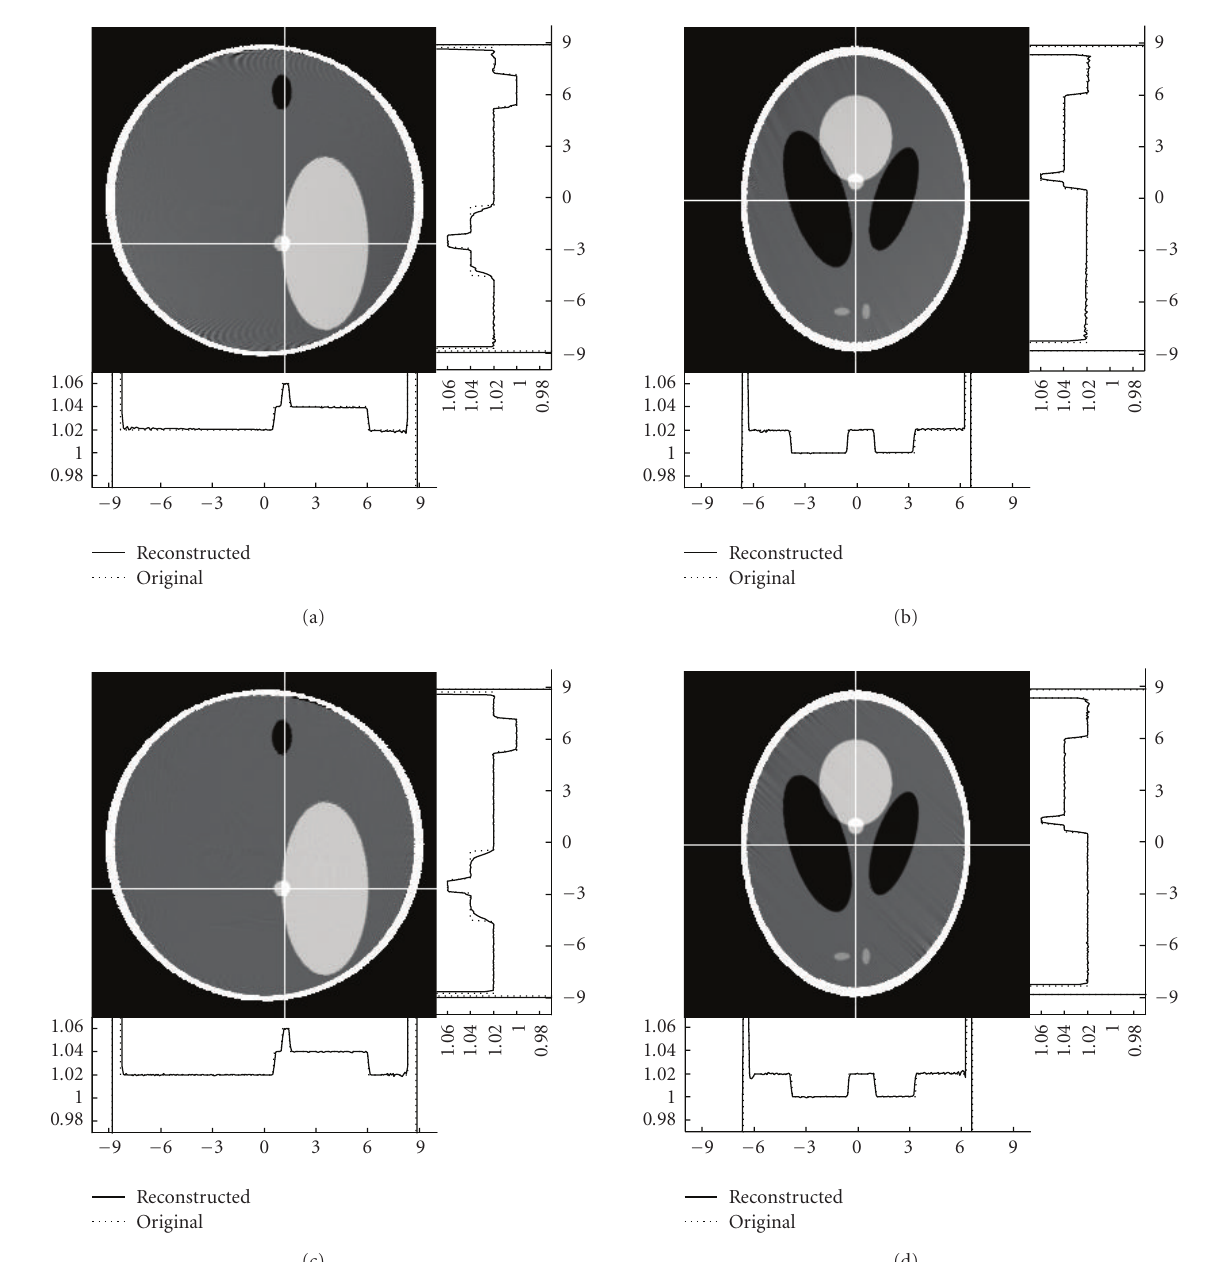
Figure 6: Reconstructed slices of the 3D Shepp-Logan phantom in the natural coordinate system with the display window [1, 1.05]. The top slices were reconstructed from noise-free data collected along the proposed composite-circling trajectory while the bottom ones were from a saddle curve [13]. The left and right slices were cut at X = 0cm and Z = − 2 . 5 cm, respectively. The two profiles were plotted along the white lines in each